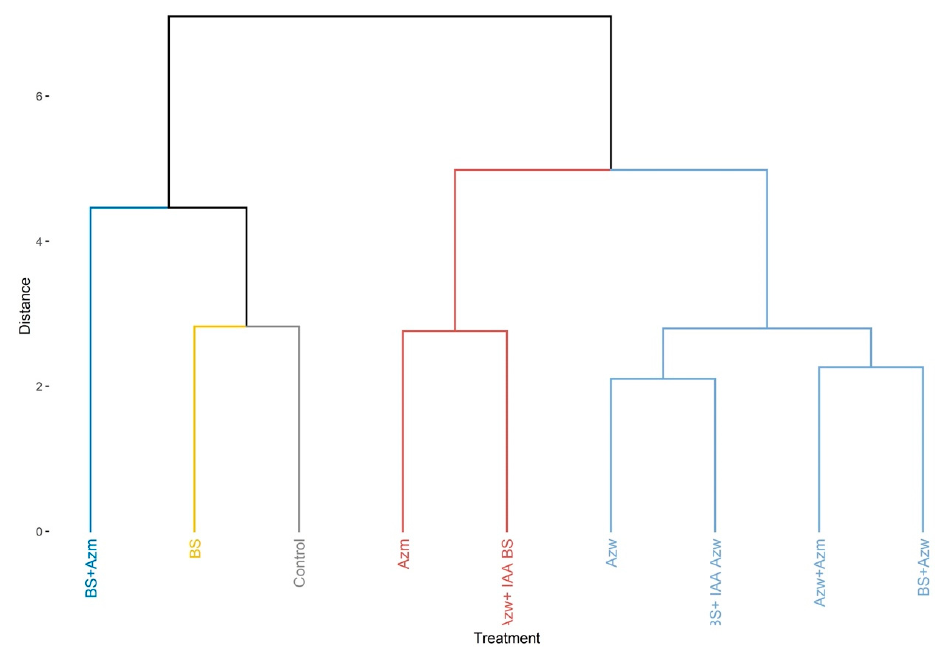
Figure 3. Hierarchical clustering of principal components (HCPCs) of inoculations tested.